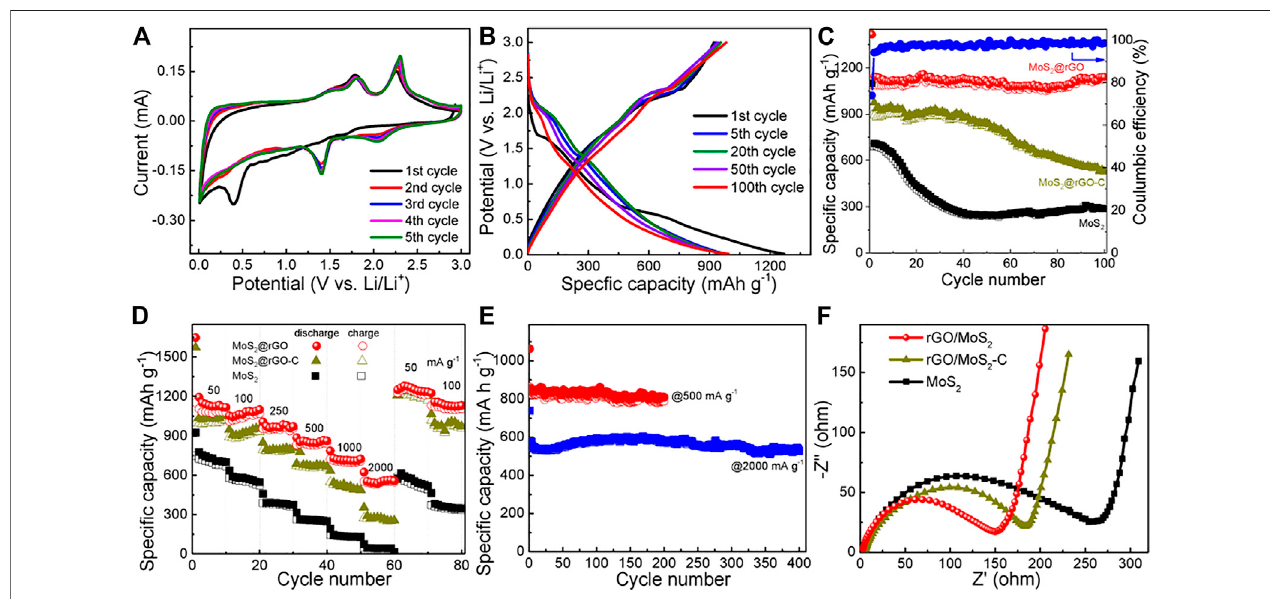
FIGURE5|(A) CVcurvesand (B) galvanostaticdischarge/chargepro fi lesoftherGO/MoS 2 electrode. (C) Cyclingperformance, (D) ratecapability,and (F) Nyquist plots of the rGO/MoS 2 , rGO/MoS 2 -C, and pure MoS 2 electrodes. (E) Cycling stability of the rGO/MoS 2 electrode at high current densities of 500 and 2000 mA g − 1 .